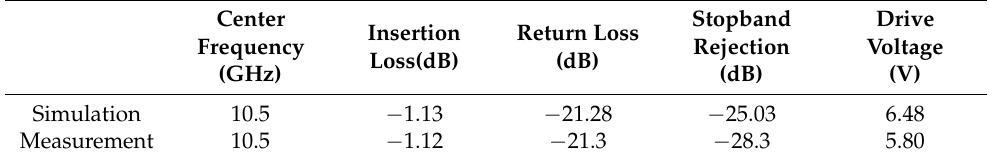
Table 3. Filter simulation results and test